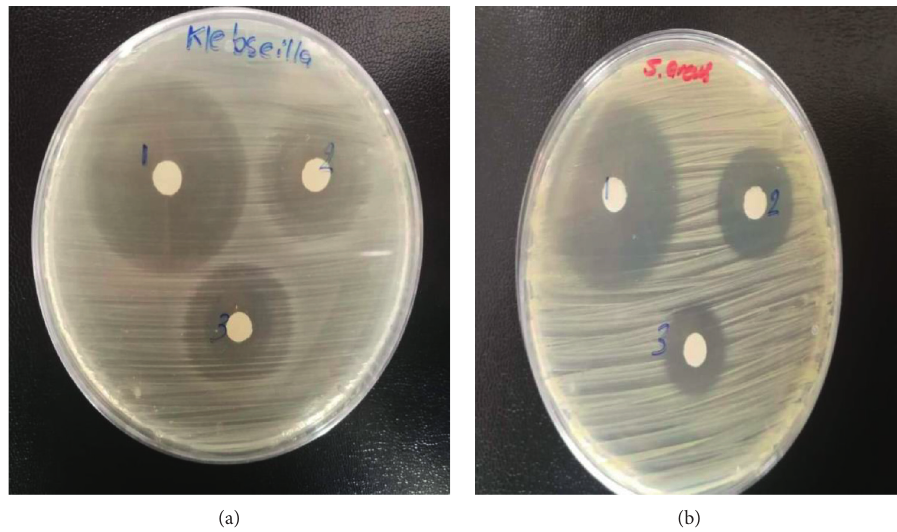
Figure 11: Inhibition zone around the discs (6mm) containing (1) CFT, (2) bulk Cu-CFTcomplex, and (3) nano-Cu-CFTcomplex placed on the surface of an LB-agar plate with (a) Klebsiella pneumonia and (b) Pseudomonas